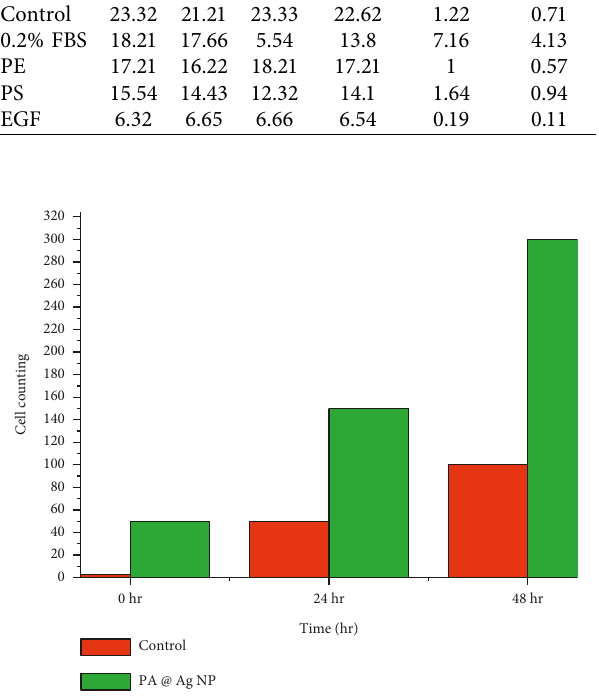
Figure 10: Cell counting for wound healing with control and PA@